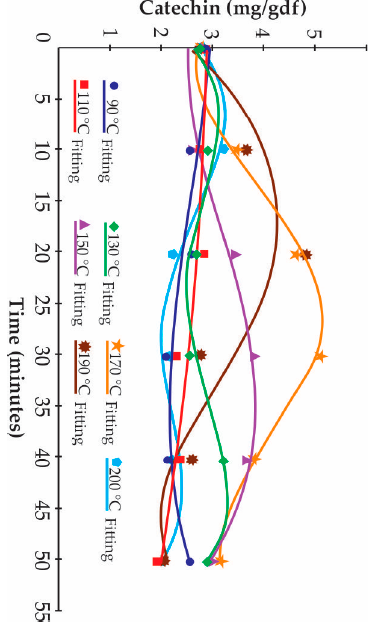
Figure 1. Kinetic of formation and degradation of